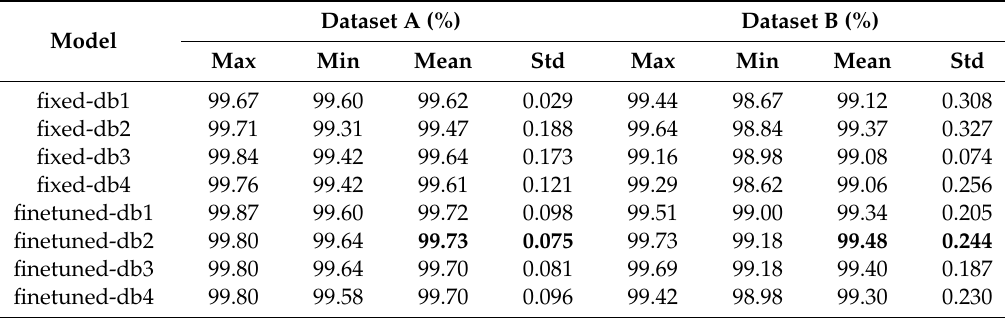
Table 5. Testing results of di ff erent model setups on two datasets in Case